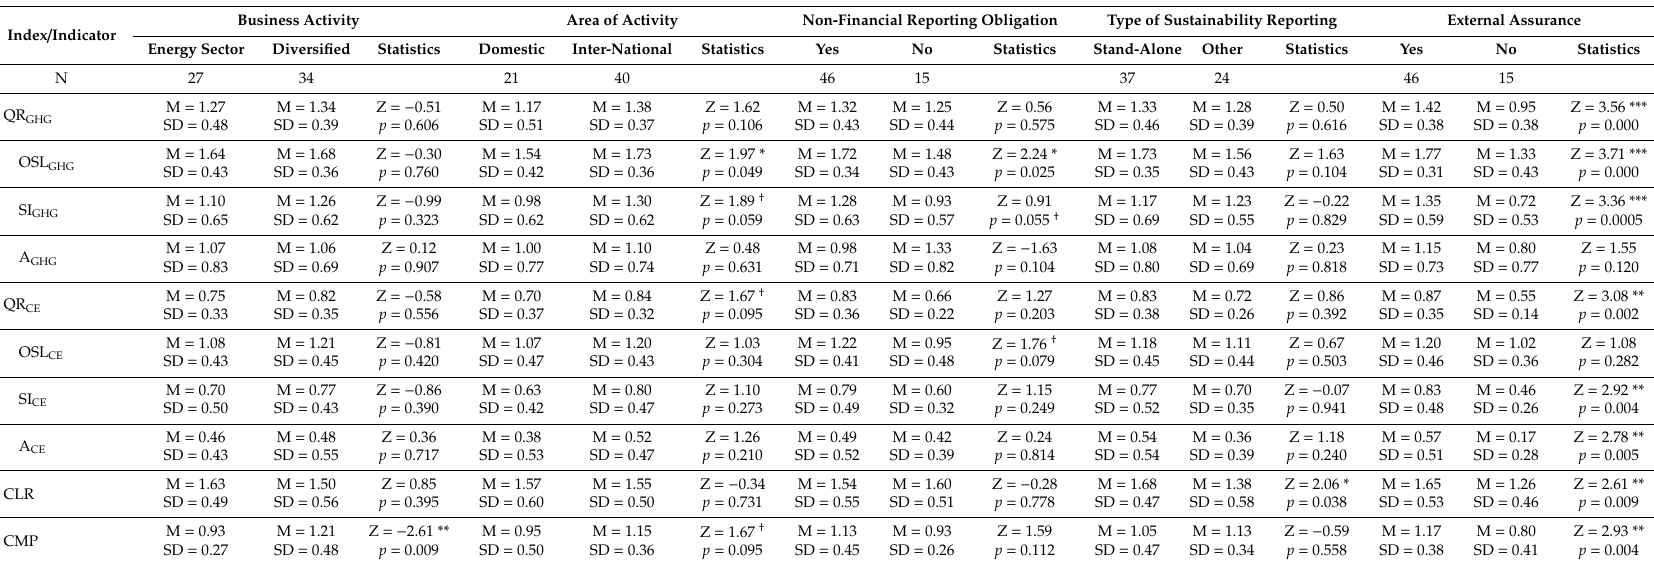
Table 4. Mann–Whitney U test results for comparison of report quality indices and indicators among the analyzed